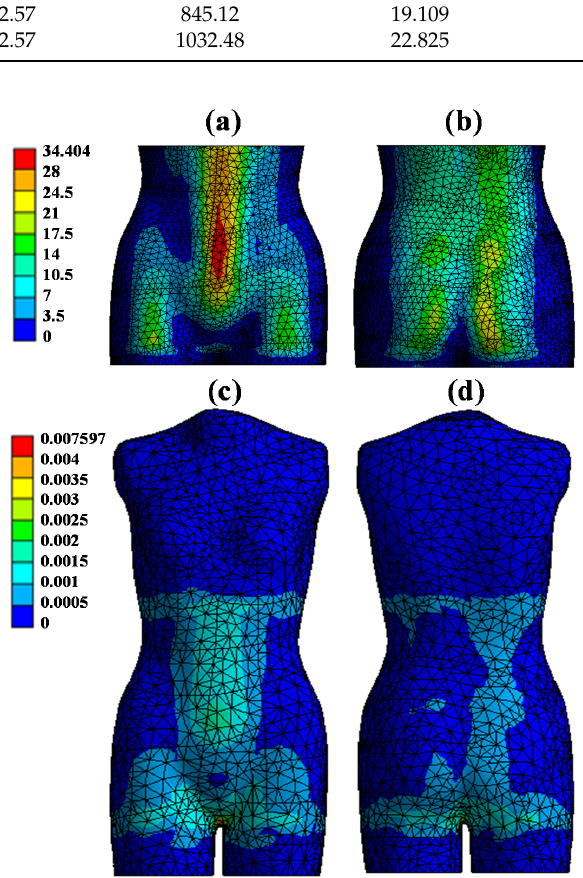
Figure 4. Von Mises stress distribution of the FEA results with BSC-1 sample during the abdomen decreasing period: ( a ) frontal view of the BSC, ( b ) back view of the BSC, ( c ) frontal view of the human body, and ( d ) back view of the human body.